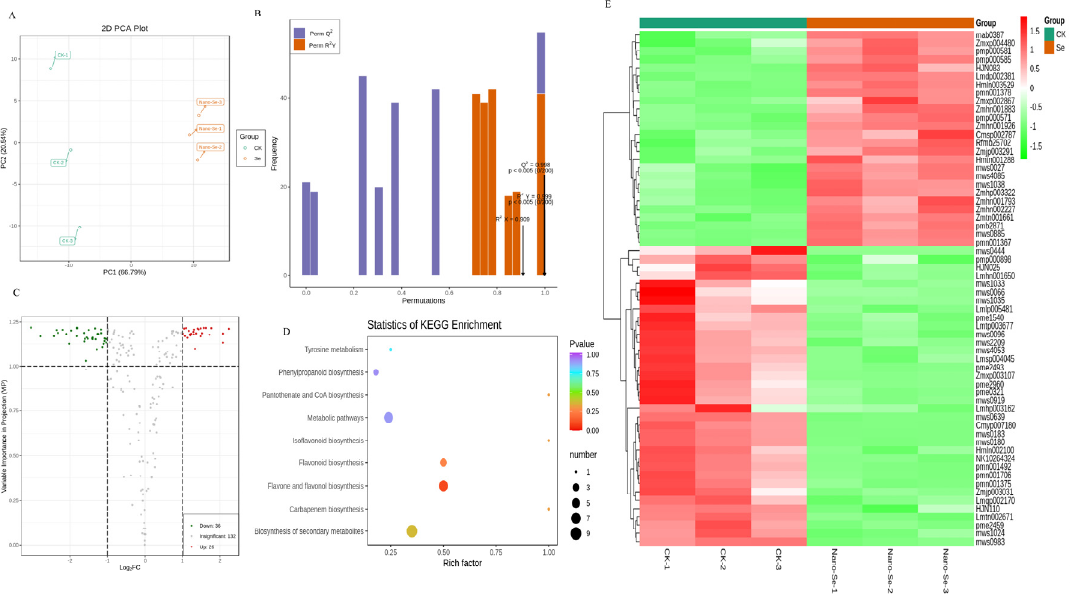
Figure 6. The principal component analysis chart of two treatments ( A ), OPLS-DA model validation diagram ( B ), volcanic maps of different metabolites ( C ), and the KEGG enrichment map of different metabolites ( D ) in S. grosvenorii . Cluster heat maps of different compounds ( E ) showed the change of metabolic compounds. Data are presented as mean ± SEM ( n = 3).